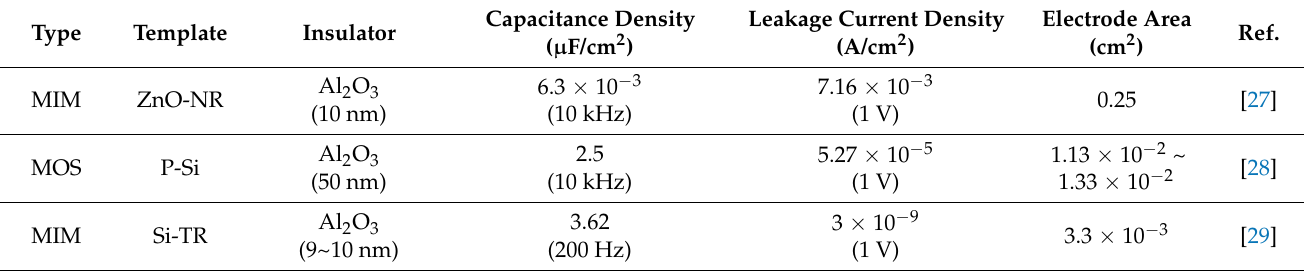
Table 1. Comparison of capacitance density and leakage current density of each capacitor with the literature. 3D structures such as ZnO nanorod (ZnO-NR), porous Si (P-Si), Si trench (Si-TR), anodic aluminum oxide (AAO), and SiNW were used as a template. Part of the data was read from the figure in each reference using a